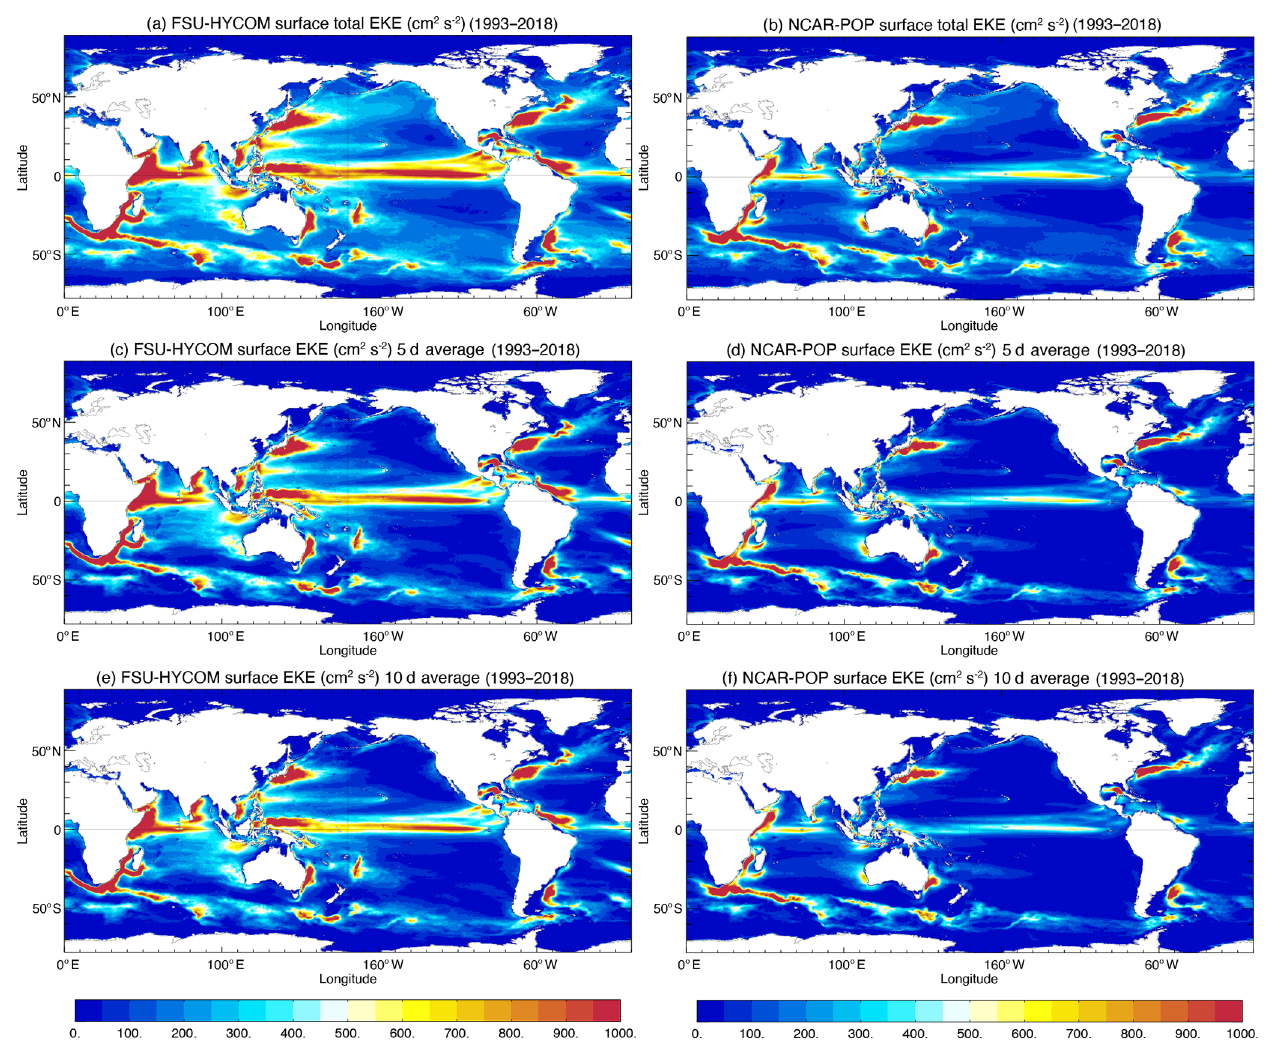
Figure 19. Comparison of surface EKE calculated from the total integrated kinetic energy, 5d average fields, and 10d average fields in the high-resolution FSU-HYCOM and